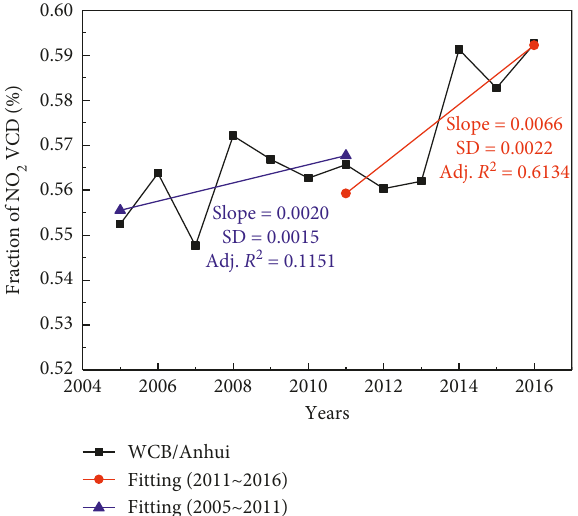
Figure 8: Fractions of OMI-derived tropospheric NO over WCB in the total tropospheric NO 2 columns of Anhui from 2005 to 2016. Fraction of tropospheric NO 2 columns is calculated as the ratio of the sum of annual averaged tropospheric NO 2 columns in WCB to the sum of annual averaged tropospheric NO 2 columns in Anhui from 2005 to 2016 (%).